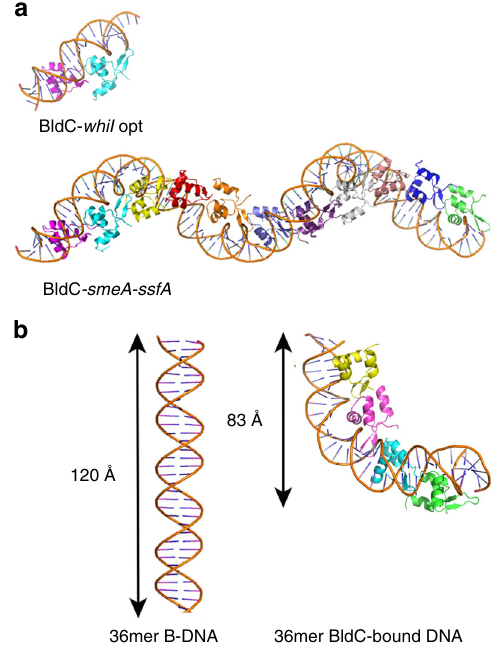
Fig. 6 Comparison of B-DNA to BldC bound DNA. a Comparison of the BldC- whiI opt and BldC- smeA-ssfA structures. BldC forms identical head-tail dimers in both structures. b The cooperative binding of multiple BldC subunits signi fi cantly distorts and shortens the